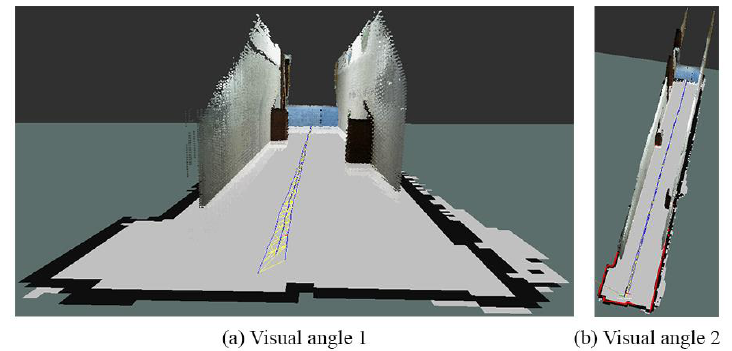
Figure 18. Composite map based on visual and laser